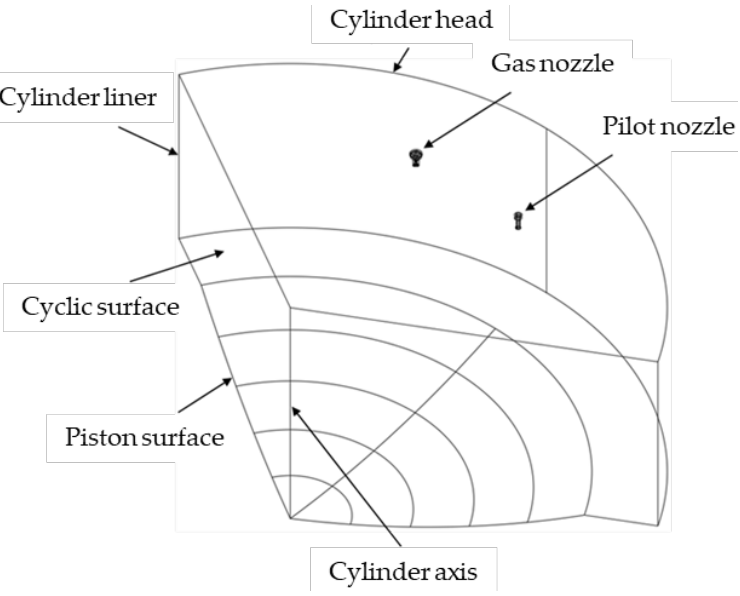
Figure 1. One-third portion of the engine combustion chamber geometry. Table 1. Specifications of the simulated engine.